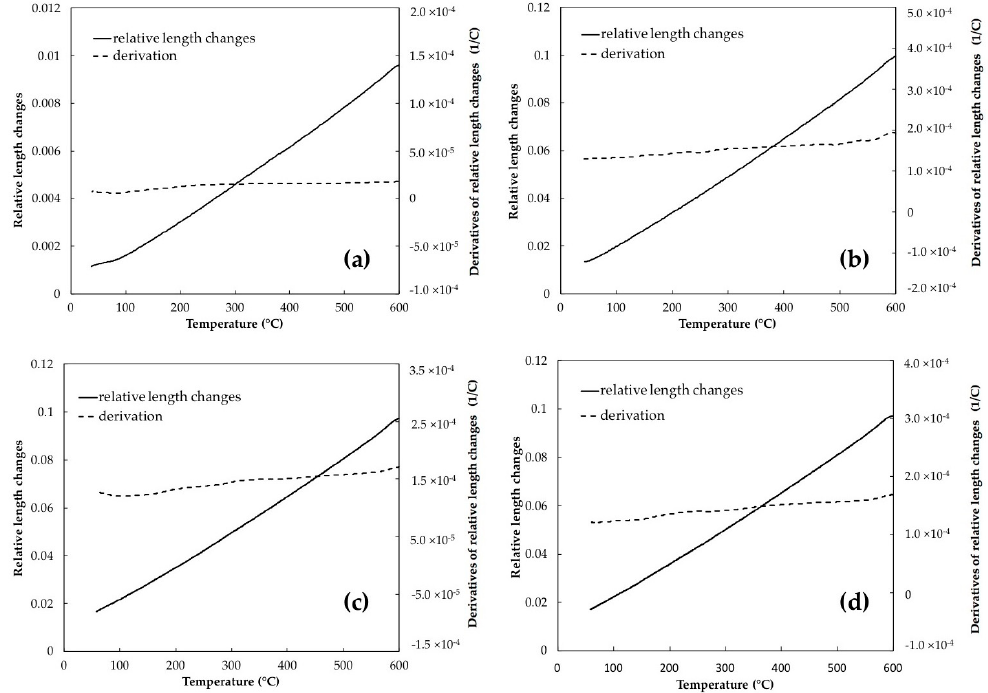
Figure 9. Relative length change and its derivation during the cooling cycle (from 600 °C to ambient temperature at a cooling rate of 600 °C/min) after tempering of: ( a ) The bainitic specimen non-isothermally tempered at a heating rate of 5 °C/min; ( b ) the bainitic specimen non-isothermally tempered at a heating rate of 30 °C/min; ( c ) the martensitic specimen non-isothermally tempered at a heating rate of 5 °C/min and ( d ) the martensitic specimen non-isothermally tempered at a heating rate of 30 °C/min.